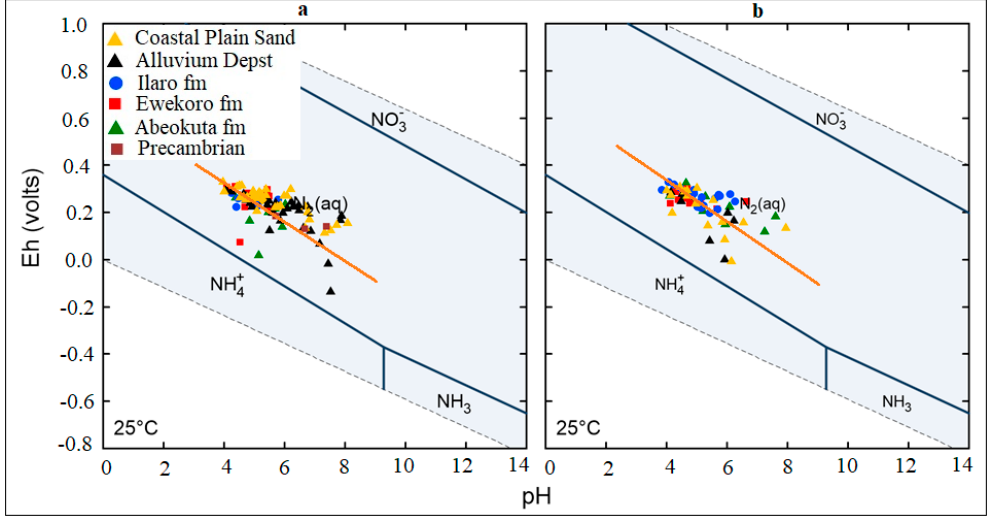
Figure 14. Redox plot for Nitrogen species in the sampled groundwater ( a ) Wet season; ( b ) dry season.